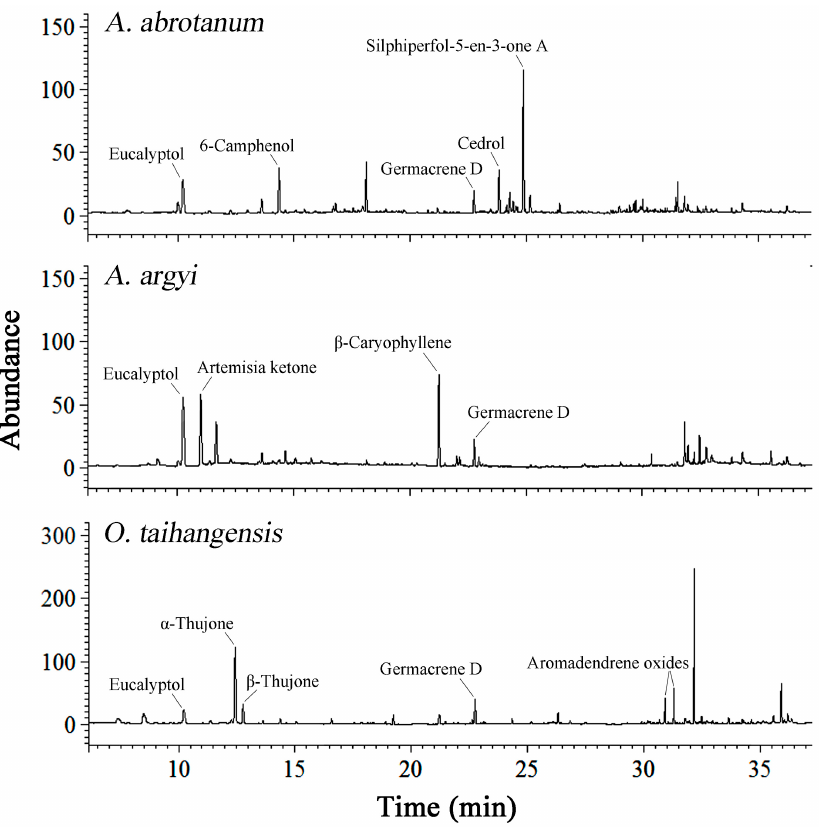
Figure 1. Total ion chromatogram of volatile components in some species of tested plants. Table 1. Number of volatile categories from leaves of 14 samples.